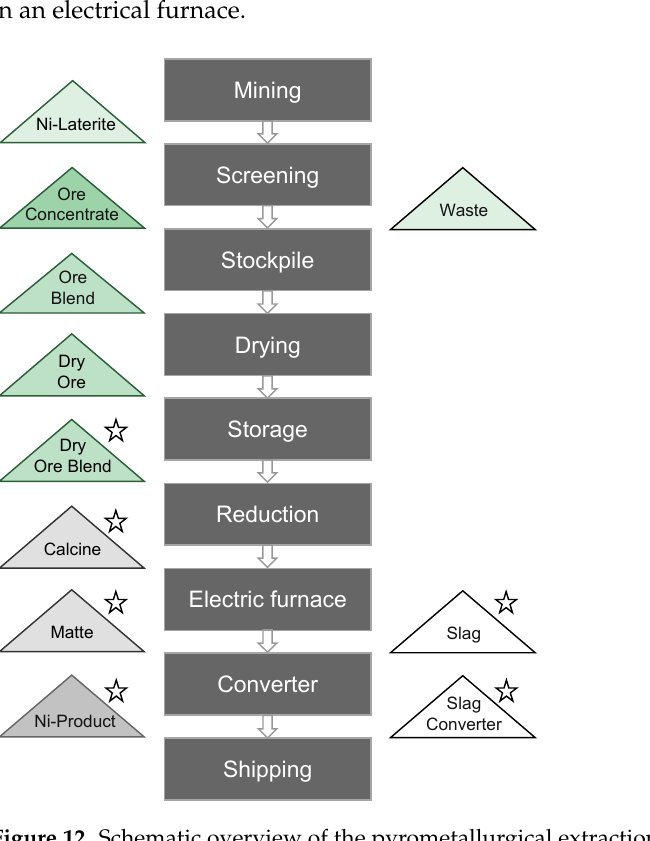
Figure 12. Schematic overview of the pyrometallurgical extraction of nickel from laterites, stars = samples analyzed.